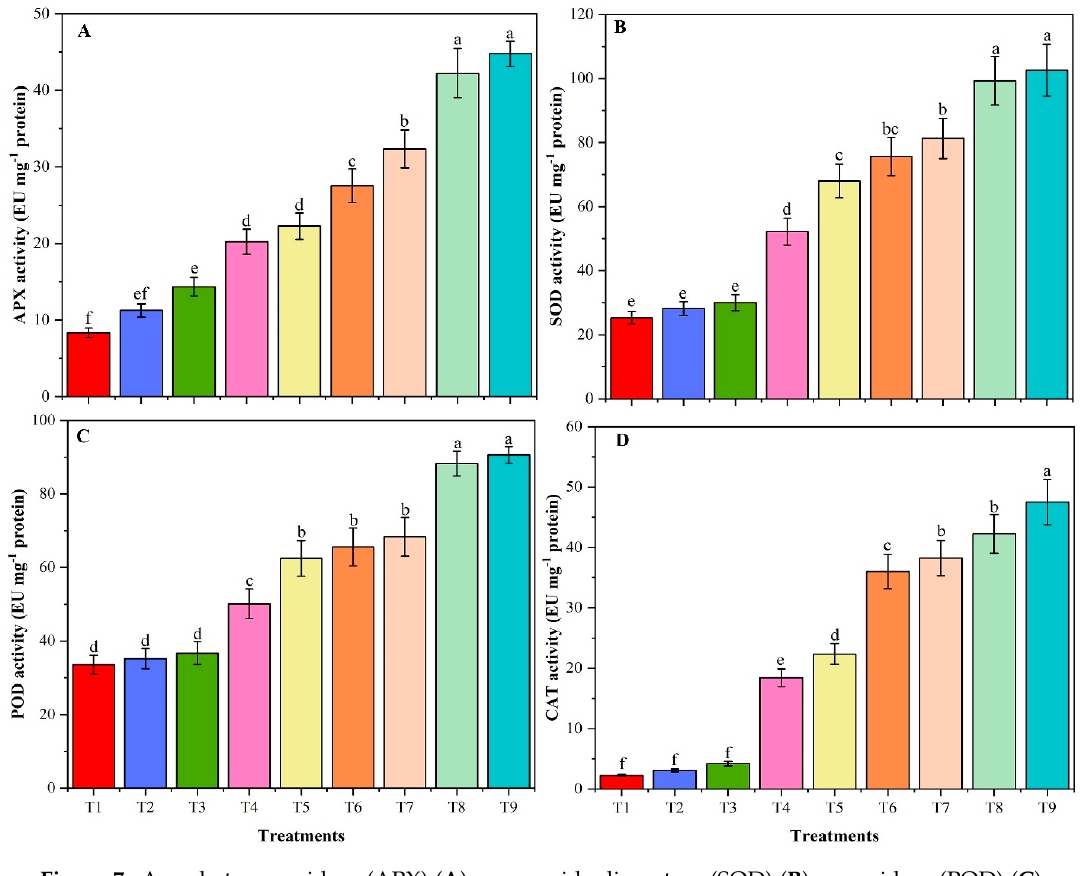
Figure 7. Ascorbate peroxidase (APX) ( A ), superoxide dismutase (SOD) ( B ), peroxidase (POD) ( C ) and catalase (CAT) ( D ) activities of un-amended and amended soybean plants with chitosan modified and as-is biochar under saline conditions. Data are shown as the mean ± standard deviation (n = 3). Different letters above the chart columns indicate significant differences among treatments ( p ≤